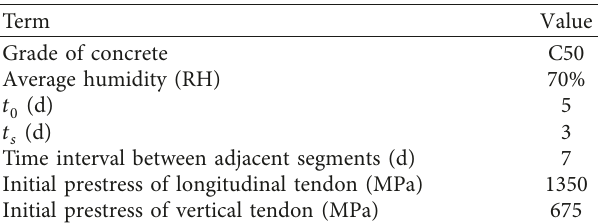
Table 1: Parameters of